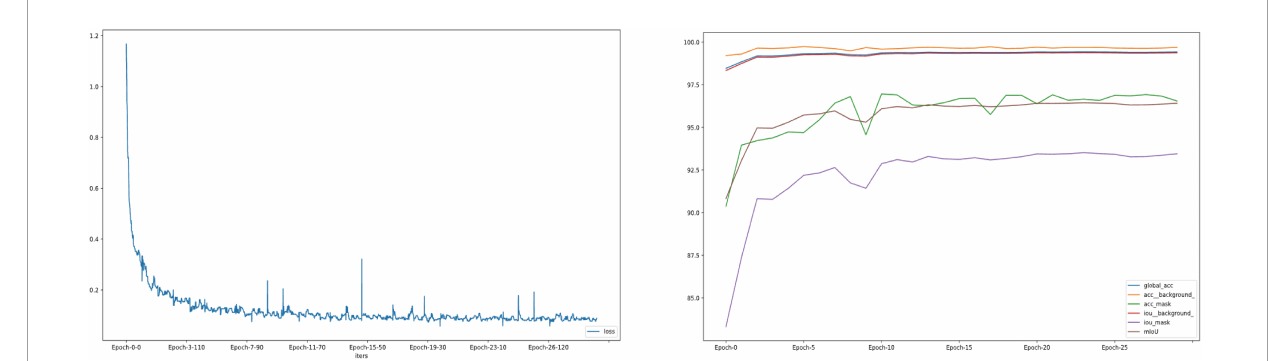
FIGURE3 The loss convergence and accuracy curves of FCNResNet50 model in the test. The loss convergence curve (left) , the pixel accuracy (PA) and Intersection over Union (IoU) curve (right) .